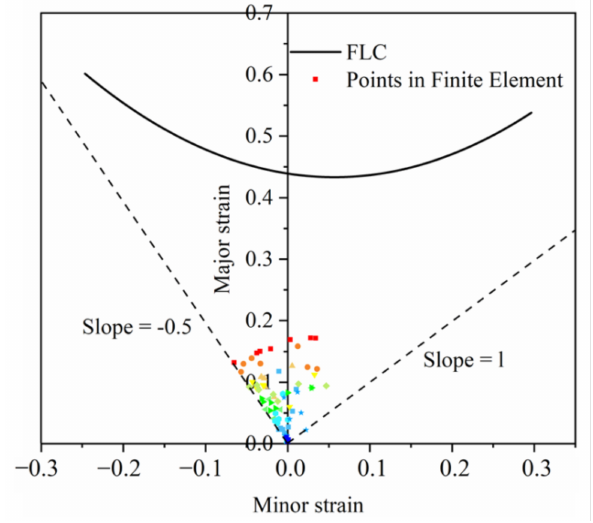
Figure 25. Forming limit result at optimal forming conditions (stamping speed of 50 mm/s, friction coefficient of 0.1, and blank holder force of 5 kN, forming temperature 410 ◦